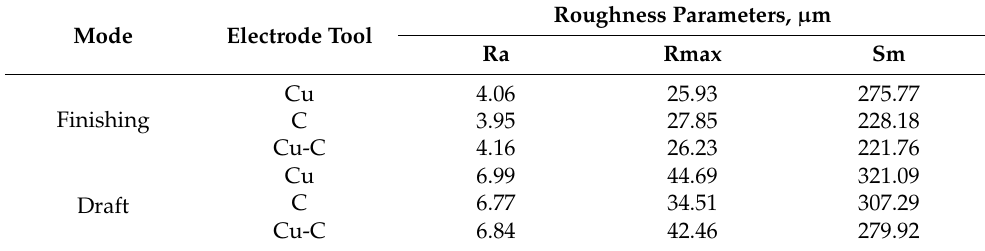
Table 7. Surface roughness after EDM.